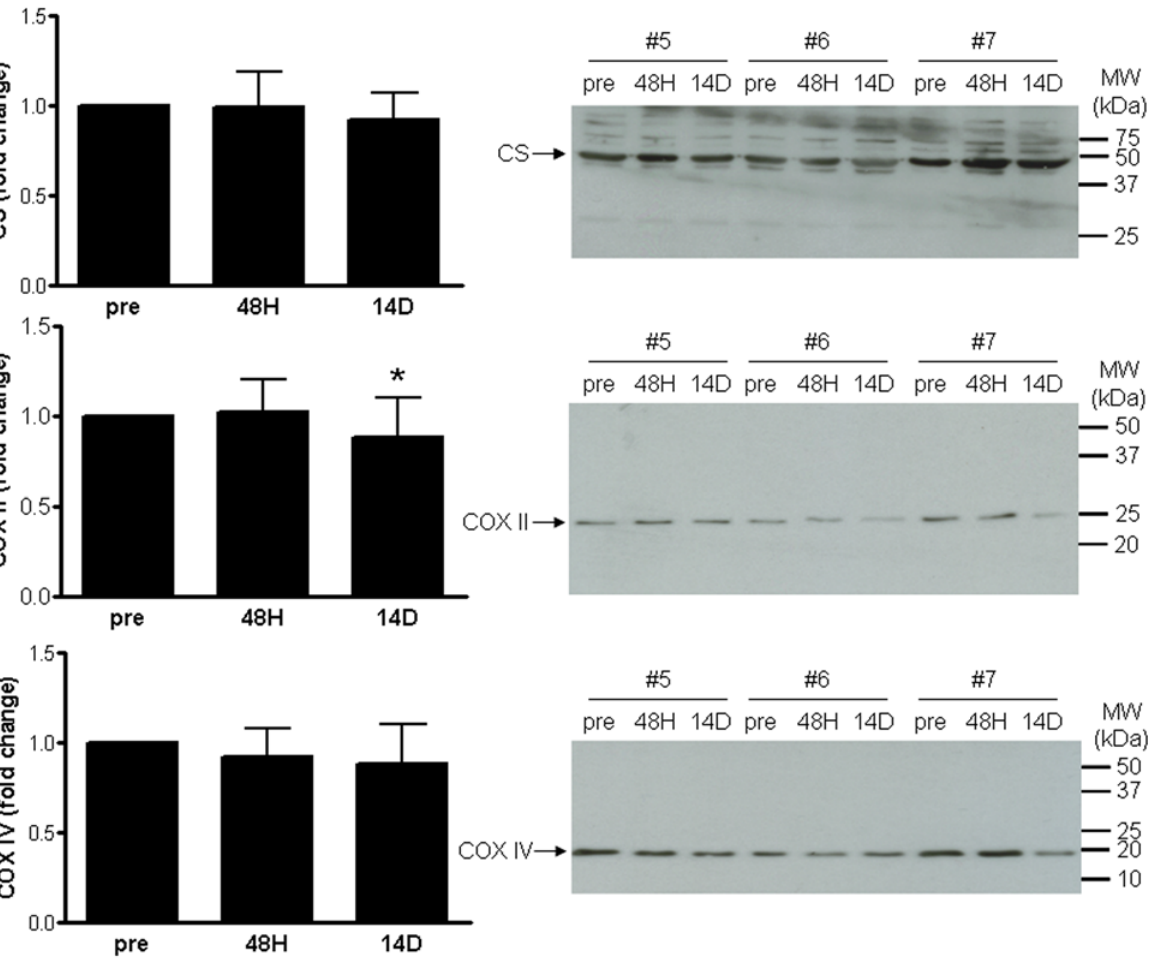
Figure 2. Changes in mitochondrial protein during immobilization-induced muscle atrophy. The protein level of the mitochondrial proteins citrate synthase (CS), cytochrome c oxidase (COX) subunits II and IV were determined by western blotting as detailed in the Materials and Methods. Protein levels were normalized to actin. Only COX II protein was significantly (P # 0.05) reduced following 14 D of immobilization (asterisk).